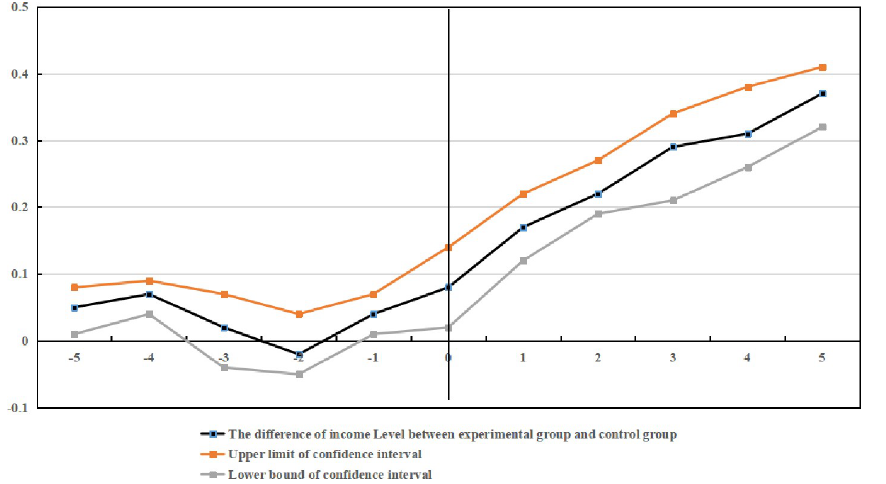
Fig 1. Bounce diagram of the income level of rural residents on two sides of the administrative boundary.